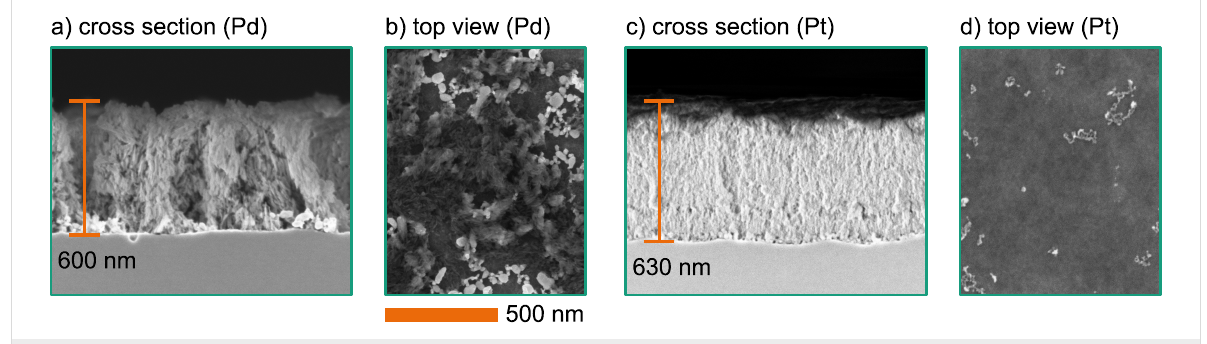
Figure 7: SEM images of etched structures (with 50 mmol/L H 2 O 2 and 1.73 mol/L HF for 10 min) using Pd particles ((a): cross section; (b): top view) and Pt particles ((c): cross section; (d): top view).